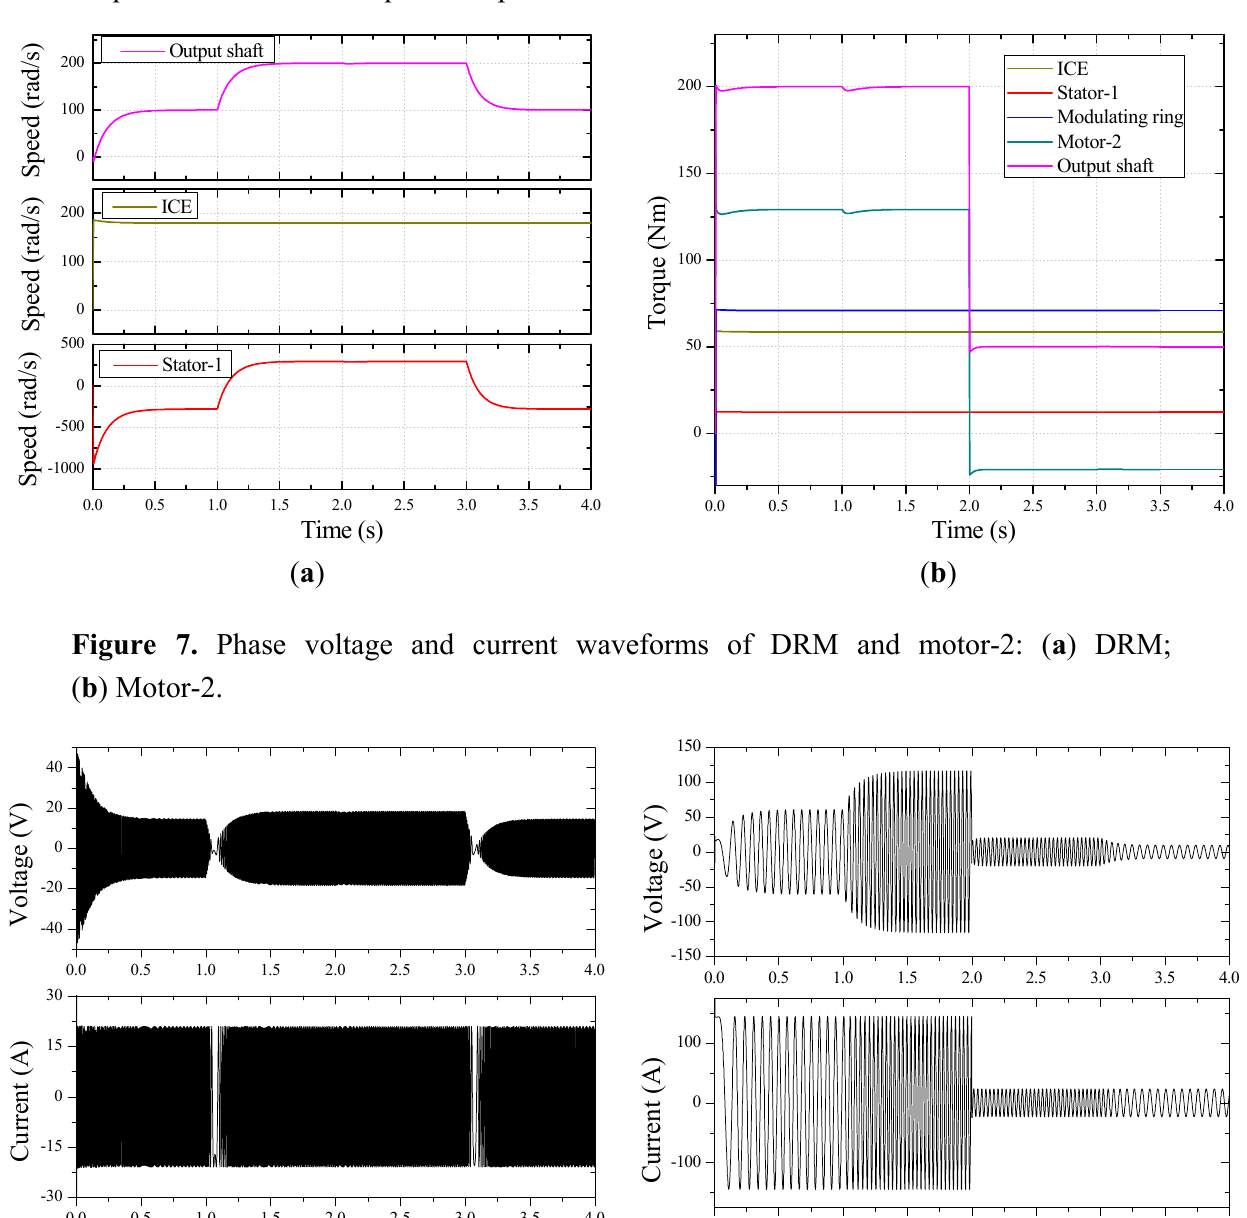
Figure 6. Simulated speed and torque waveforms: ( a ) Speeds of output shaft, ICE and rotating magnetic field generated by stator-1; ( b ) Torque delivered from ICE, electromagnetic torque of stator-1, torque delivered to modulating ring, electromagnetic torque of motor-2 and torque of output shaft.